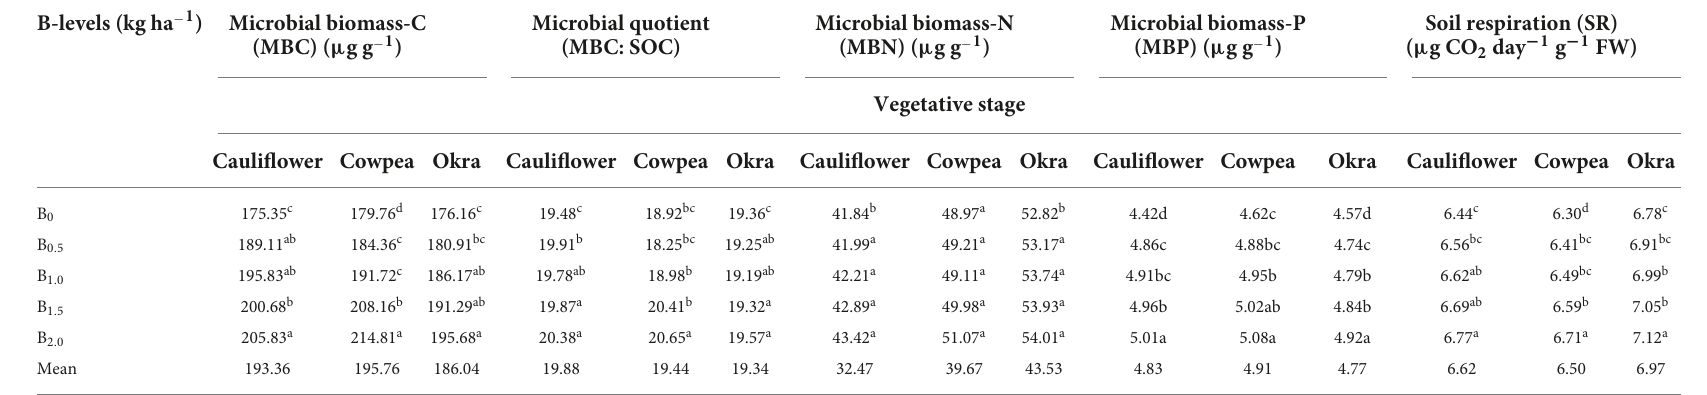
TABLE 2 Effect of graded B levels on microbiological pools of soil organic matter at different crop stages in cauliflower-cowpea-okra cropping system (Pooled data 2015–2017). B-levels (kg ha − 1